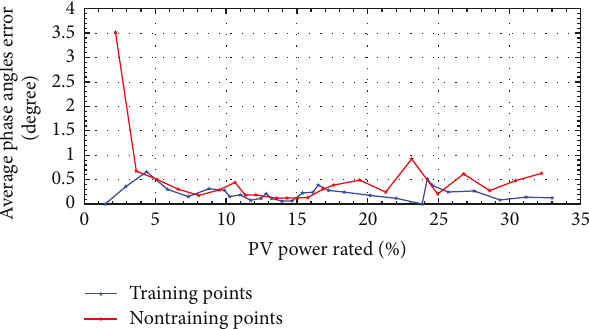
Figure 13: The average error between DDM and real measurement at nontraining point (grid voltage: 200 V, 220 V; power: 35–100%).